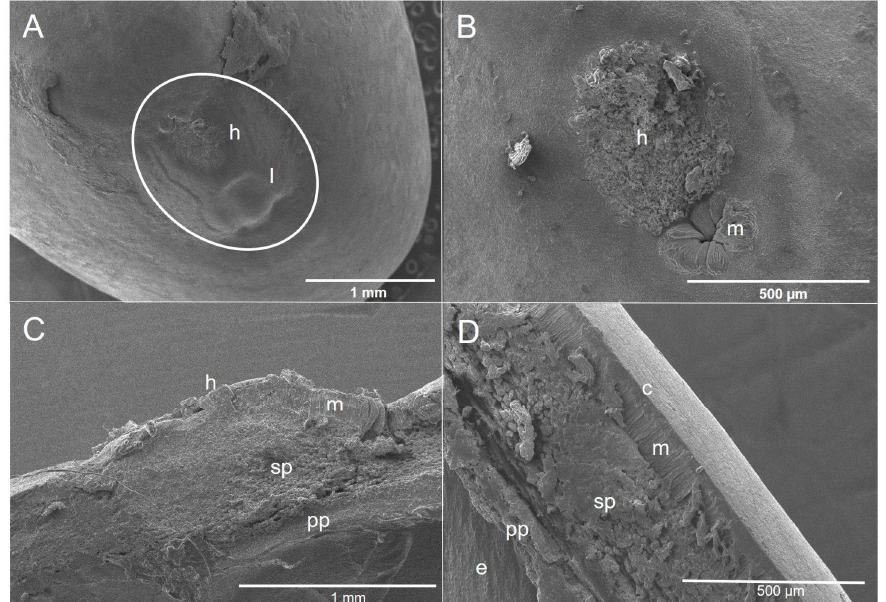
Figure 4. Morphological characterization of the Enterolobium cyclocarpum seed coat. ( A ) External section, h, hilum, l, lens ( B ) Detail of the hilar region: h, hilum, m, micropyle, ( C ) Longitudinal section of the hilar region: h, hilum, m, macrosclereids, sp, spongy parenchyma, pp, palisade parenchyma, ( D ) Longitudinal section of the epidermis: c, cuticle, e, embryo, m, macrosclereids, sp, spongy parenchyma, pp, palisade parenchyma.